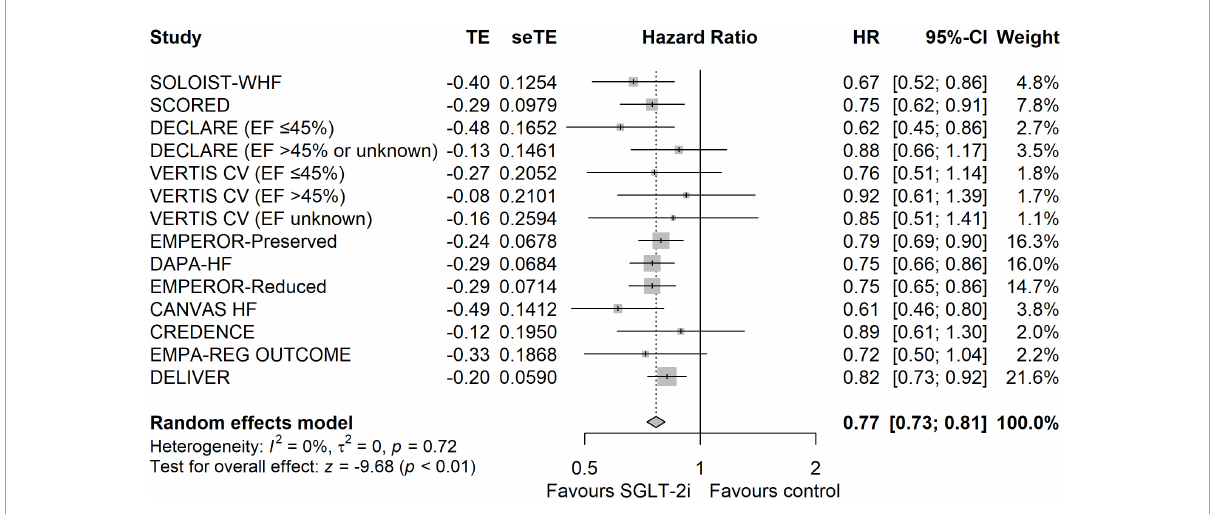
FIGURE1 The forest plot of meta-analysis in terms of composite outcome of cardiovascular death or hospitalization due to heart failure.